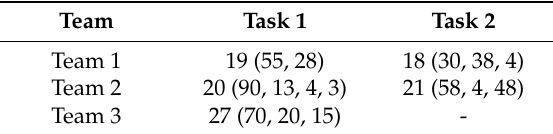
Table 14. Scheme 2 for system